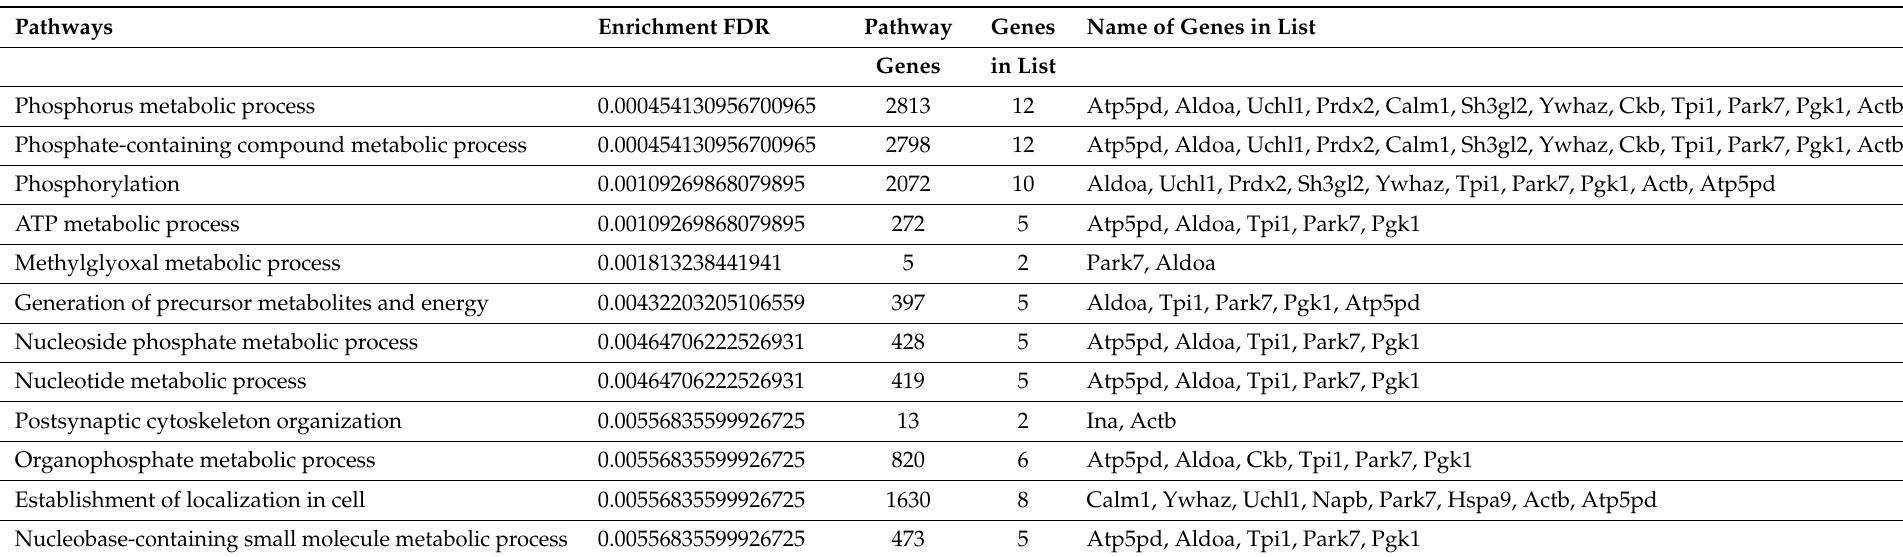
Table 3. GO enrichment analysis for significantly upregulated and downregulated proteins identified in the rat hippocampus isolated from animals after 6 months of morphine withdrawal; carried out using the ShinyGO v0.74 tool (bioinformatics.sdstate.edu/go). The top thirty most significantly enriched GO terms for biological processes are